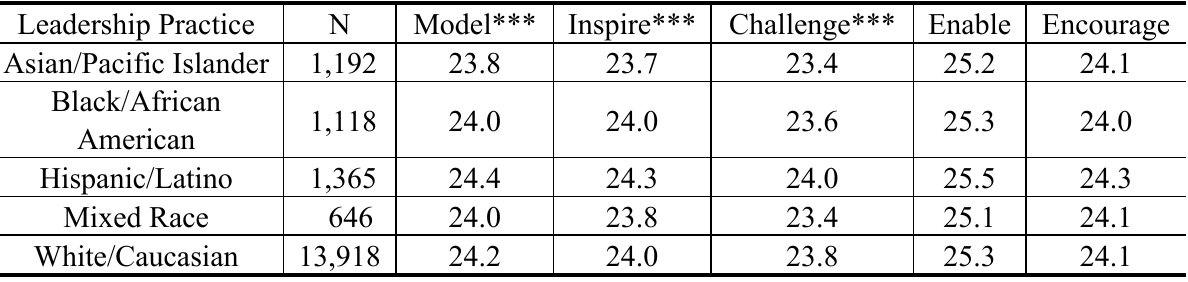
Table 4b. Comparisons between United States Respondents on the Basis of Ethnic Background